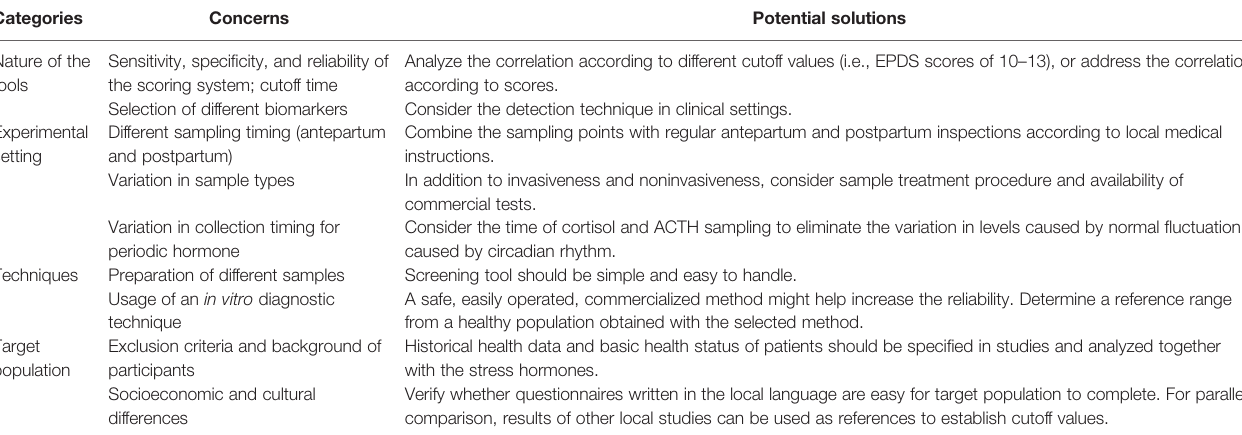
TABLE 3 | Main experimental concerns and potential solutions involving the detection of HPA axis